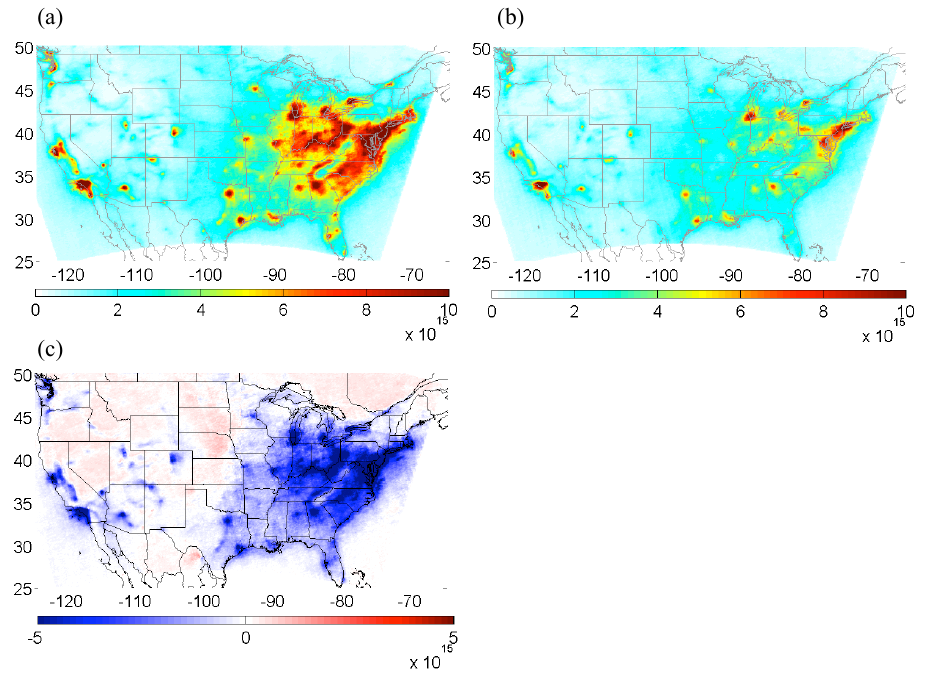
Fig. A1. Average wintertime (October–March) OMI NO 2 column densities for (a) 2005, (b) 2011, and (c) the difference,